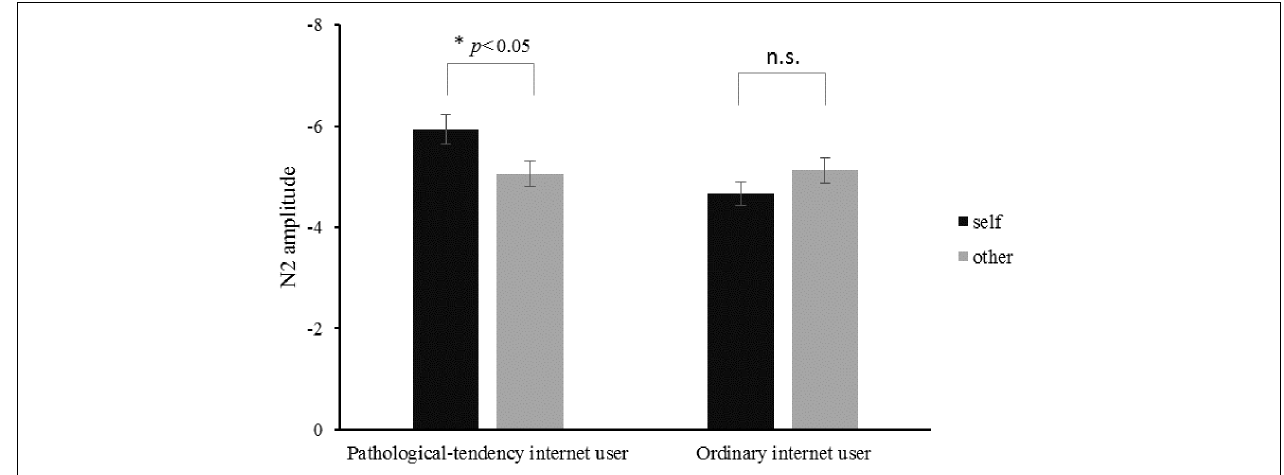
FIGURE 4 | Mean amplitudes of the N2 components in the self priming and other priming conditions in pathological-tendency Internet user and ordinary Internet user. Asterisks indicate the significant difference at ∗ p < 0.05 level, ns, no significant difference.